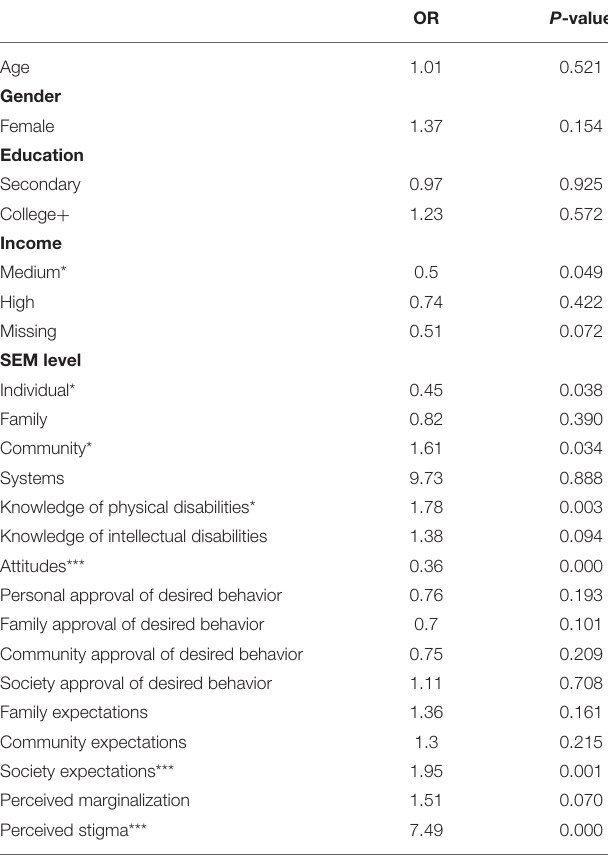
TABLE 4 | Bivariate logistic regression results with stigma as the dependent variable.